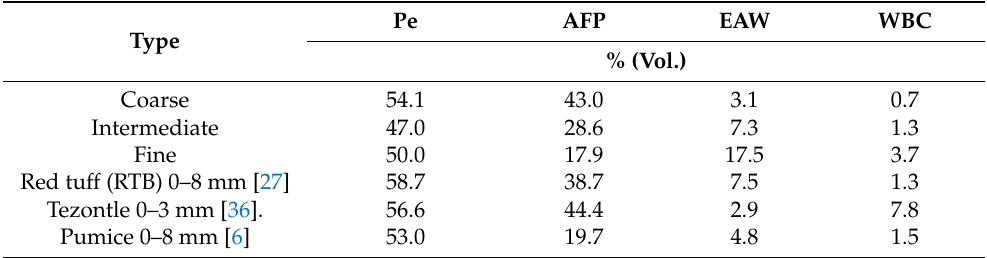
Figure 5. Mean fitted water retention curves of the three tephra types. Mean air–water relations of three tephra groups compared with other volcanic Table 2. Air–water relations for the tephras analysed (arranged in descending CI). materials mm